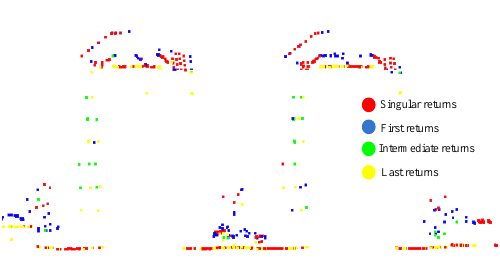
Figure 2. Relationship between types of echoes and types of objects in urban areas （ Xiangguo Lin ， 2011